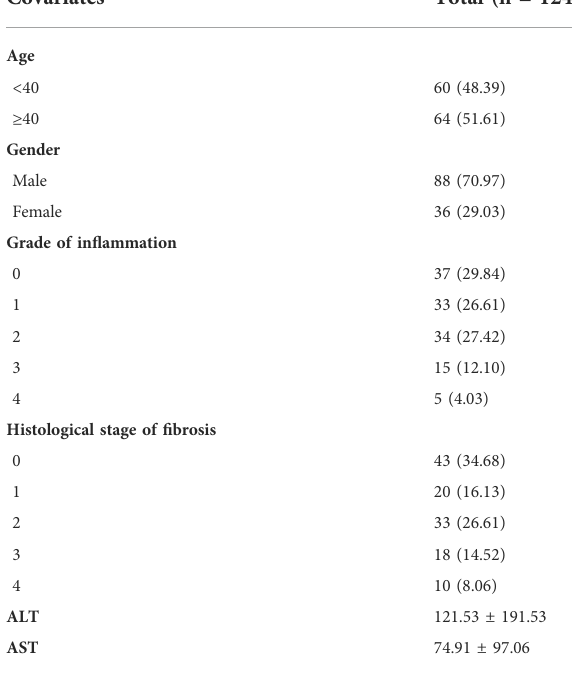
TABLE 1 Clinical information of patients in the